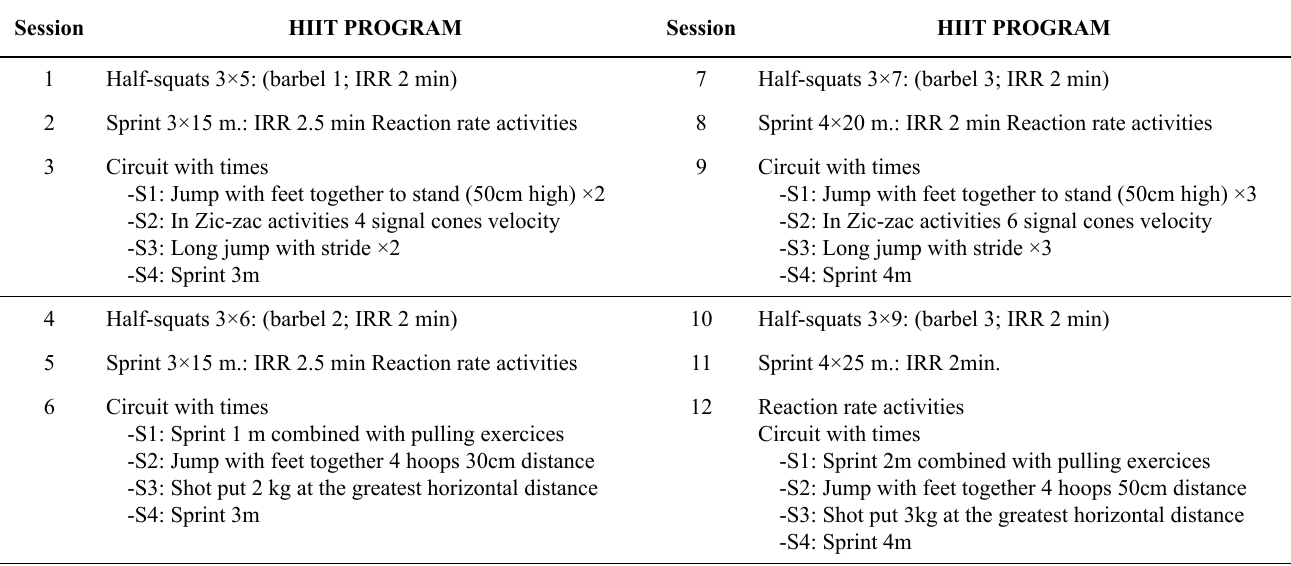
Table 1. Details of the first 20 minutes of each high-intensity interval training (HIIT) session carrying weights, pulling